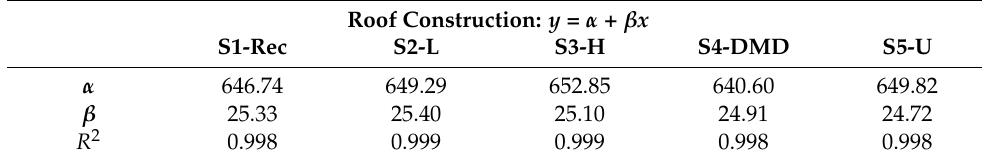
Table 10. Summary of roof construction regression equations.